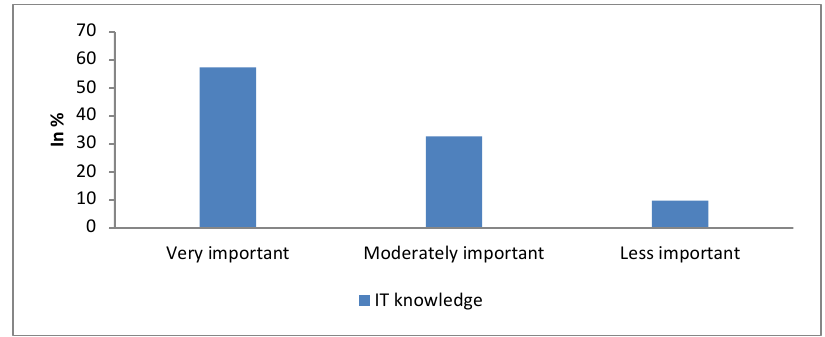
Figure 2: Stated importance on the IT